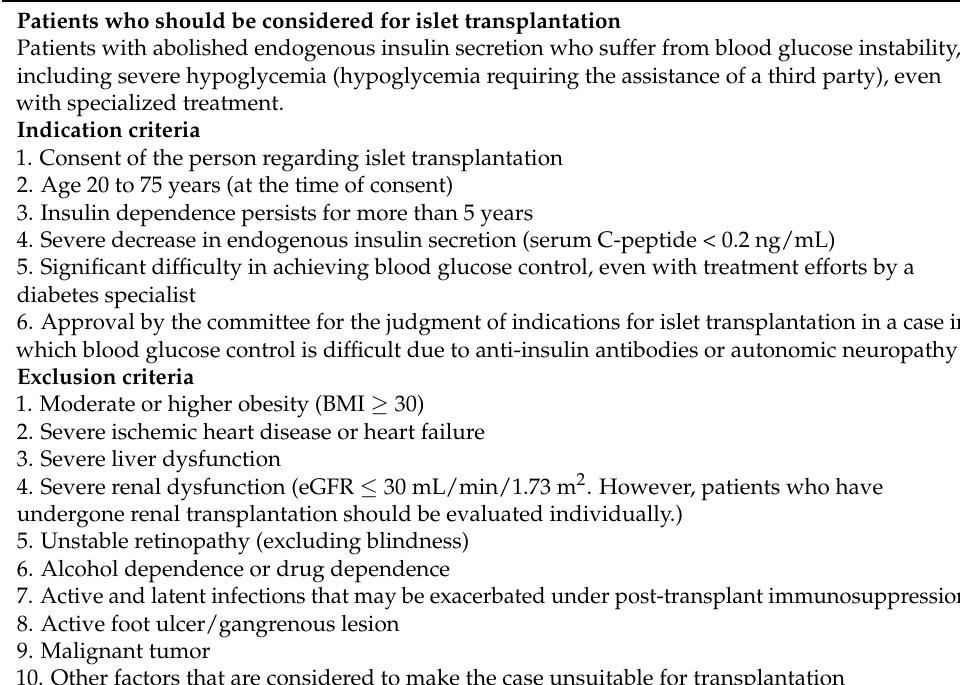
Table 2. Indication criteria for islet transplantation. Patients who should be considered for islet transplantation Patients with abolished endogenous insulin secretion who suffer from blood glucose instability, including severe hypoglycemia (hypoglycemia requiring the assistance of a third party), even with specialized treatment.